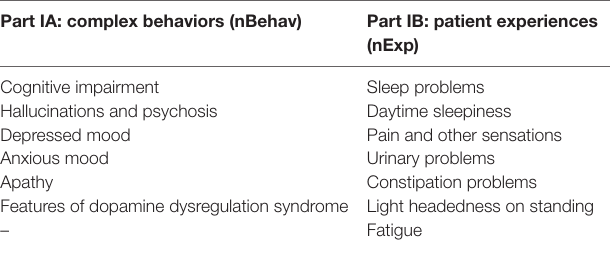
TaBle 2 | The six different tests that composed subscore ia (nBehav) and the seven different tests that composed subscore iB (nexp). Part ia: complex behaviors (nBehav)